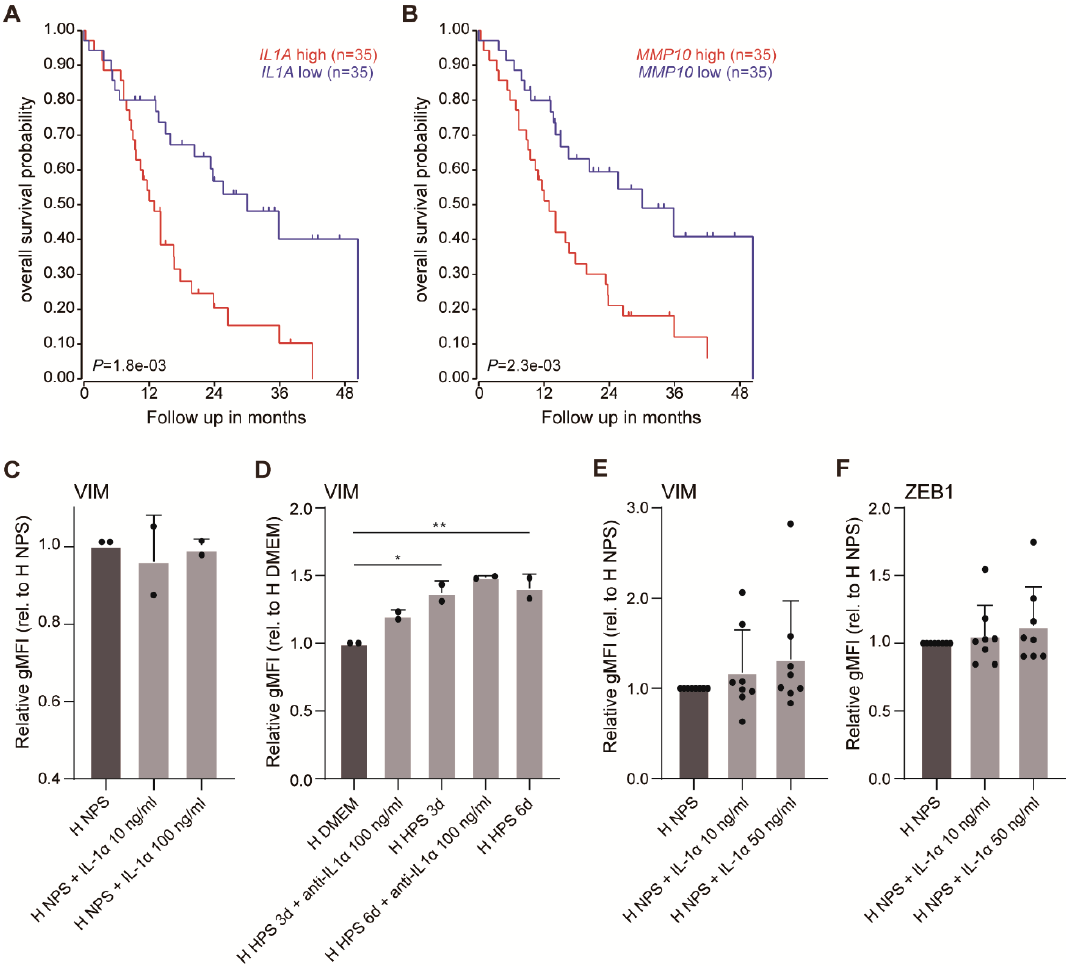
Figure A3. Upregulation of IL1A or MMP10 correlates with poor prognosis. ( A ) Survival analysis on PDAC samples dichotomized by median IL1A and MMP10 ( B ) are shown. ( C ) PANC-1 and MIA PaCa-2 were cultured in NPS, NPS + IL1 α 10 ng / mL and NPS + IL1 α 100 ng / mL under hypoxia for 3 days before flow cytometry was performed for VIM expression. Levels of average gMFI ± S.E.M. were normalized to NPS group (* p < 0.05, ** p < 0.01). A dot refers to a cell line. ( D ) Both cell lines were also incubated in unconditioned medium, HPS, and HPS + anti-IL1 α 100 ng / mL under hypoxia for 3 or 6 days. Values were normalized to unconditioned medium group. ( E , F ) Expression of VIM and ZEB1 in AMC-PDAC-053M, AMC-PDAC-067, AMC-PDAC-099, AsPC-1, Hs 766T, PSN-1, PANC-89,